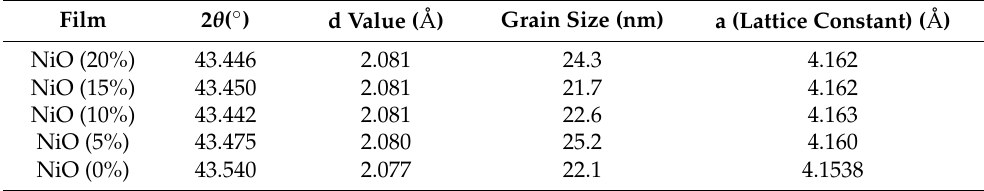
Table 1. Structural parameters of undoped and lithium doped NiO thin